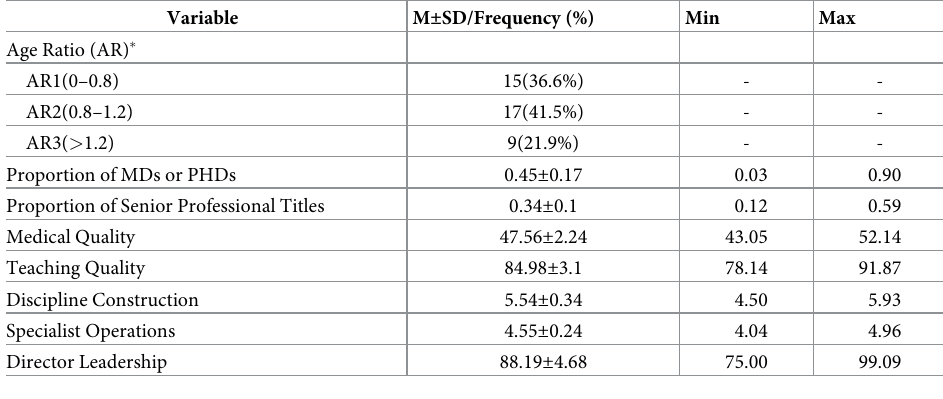
Table 4. Characteristics of the influencing factors ( n =